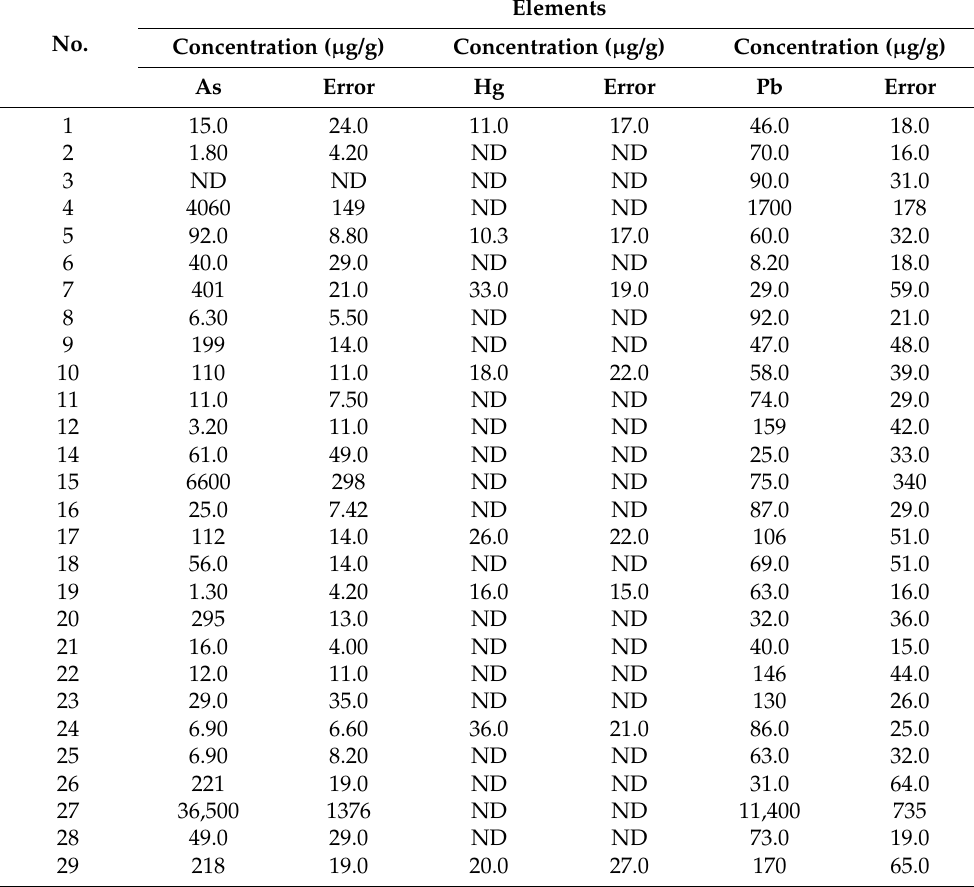
Table 1. Concentrations of As, Hg, and Pb in the soil samples along the Bone River.